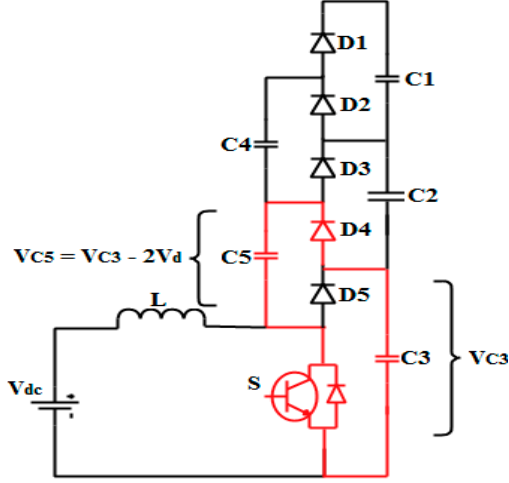
Figure 5. Charging C5 of a TLBC with switch and diode’s voltage drop.